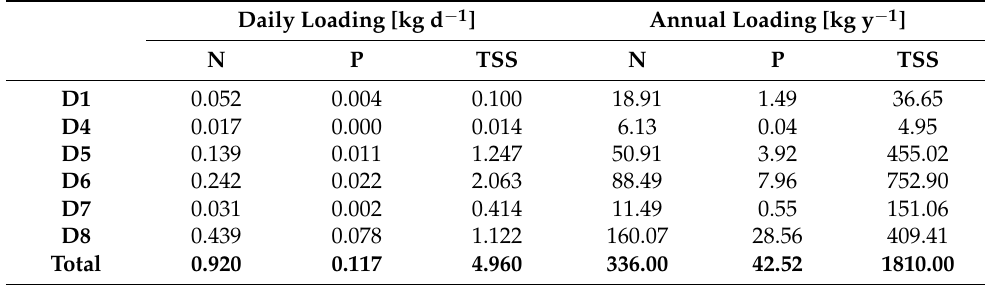
Figure 3. Changes of TN ( A ) and TP ( B ) loads in tributaries of Raczyńskie Lake and in Kamionka River. Table 3. Mean daily and annual loads of nitrogen (N), phosphorus (P) and total suspended solids